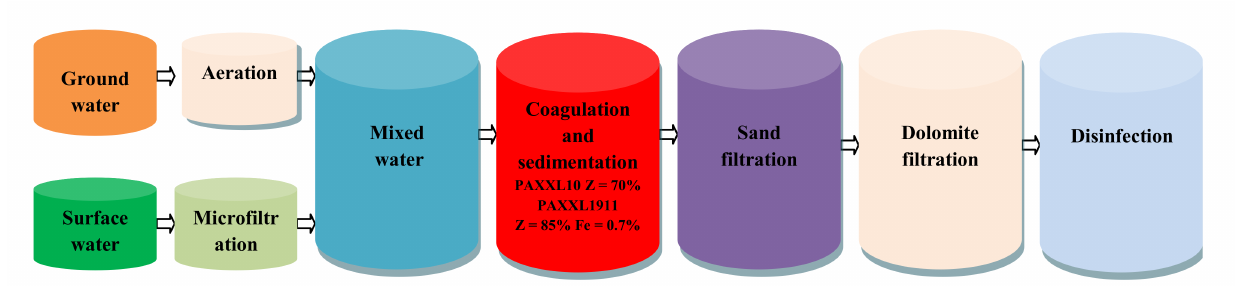
Figure 13. Water treatment scheme applied in the “Zawada” Water Treatment Plant in Zielona G ó